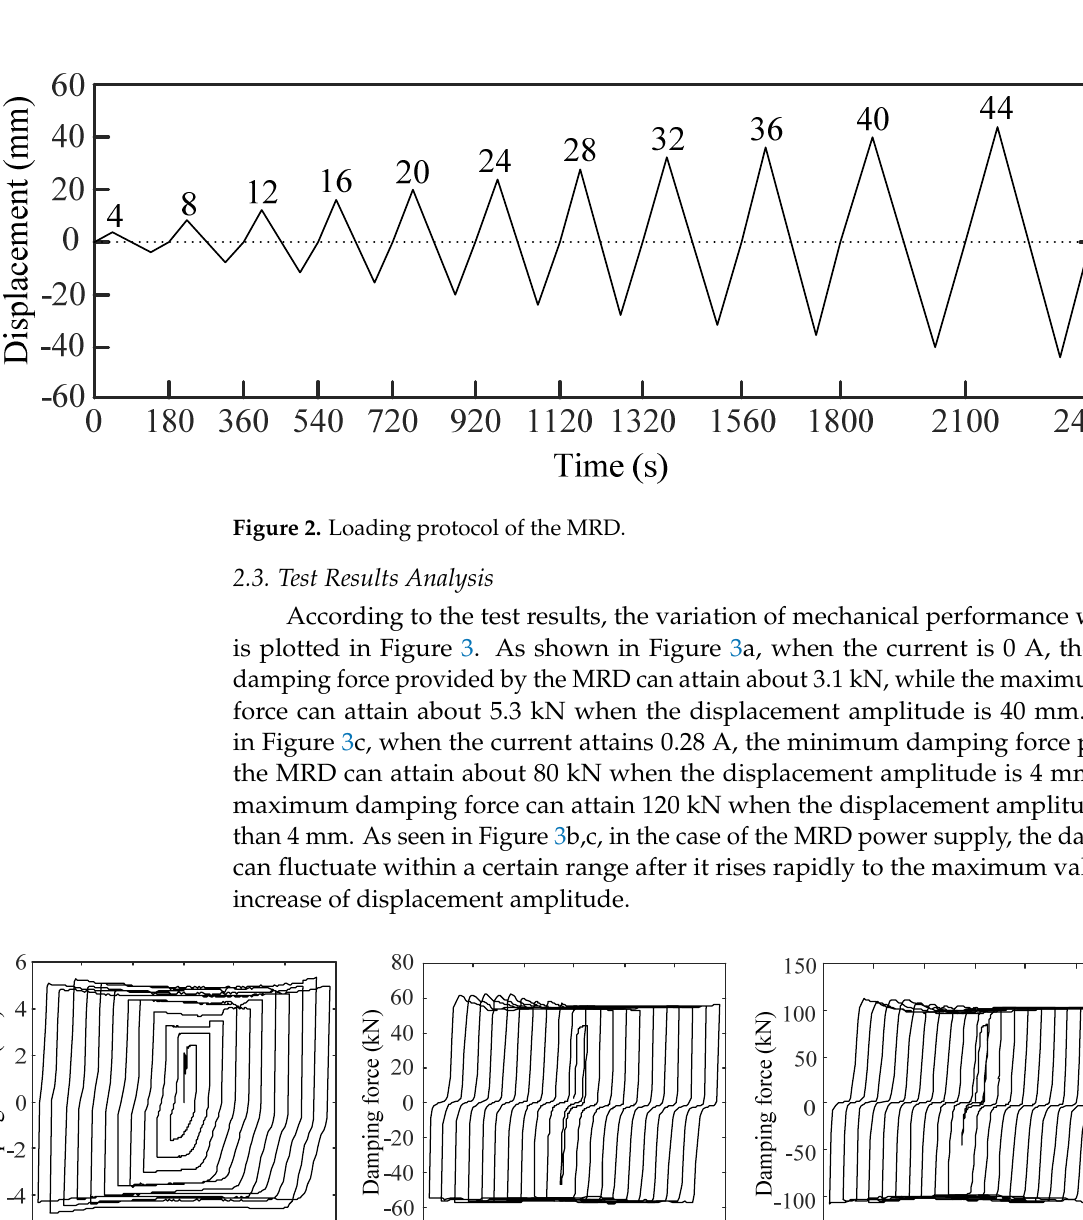
Figure 3. Damping force-displacement hysteresis curve of the MRD at different currents. 3. Modeling Theory of the L-Shaped Frame Structure 3.1. Theory of Spatial Beam Element For the spatial beam element, as shown in Figure 4, every node has 6 degrees of free- dom (DOFs), where u, v, and w are the axial displacements in x, y, and z directions, re- spectively; Figure 4. Node displacement and DOF number of beam element.